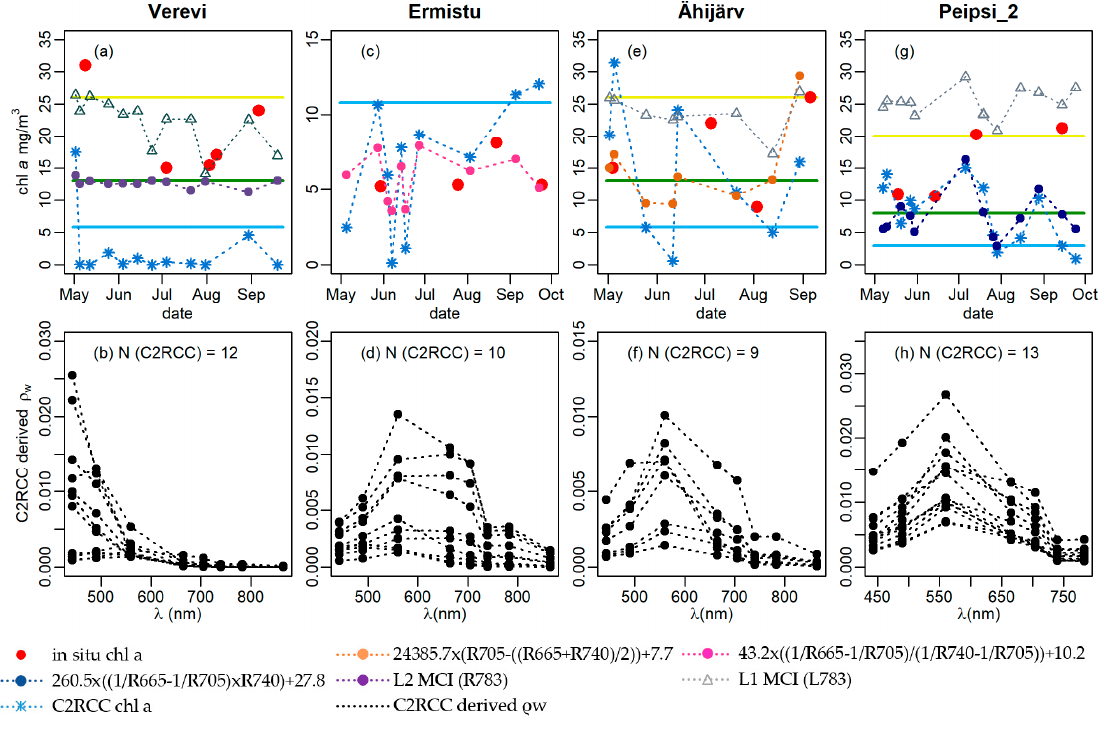
Figure 6. Estimation of Chlorophyll a (chl a ) seasonal dynamics in Verevi (2017) (Type 3) (a), Ermistu (2017) (Type 2) (c), Ähijärv (2017) (Type 3) (e), and Peipsi_2 (2016) (Type 6) (g) and C2RCC derived ρ w on each lake (b,d,f,h). Color bars represent the thresholds of ecological classes as shown in Table 2.